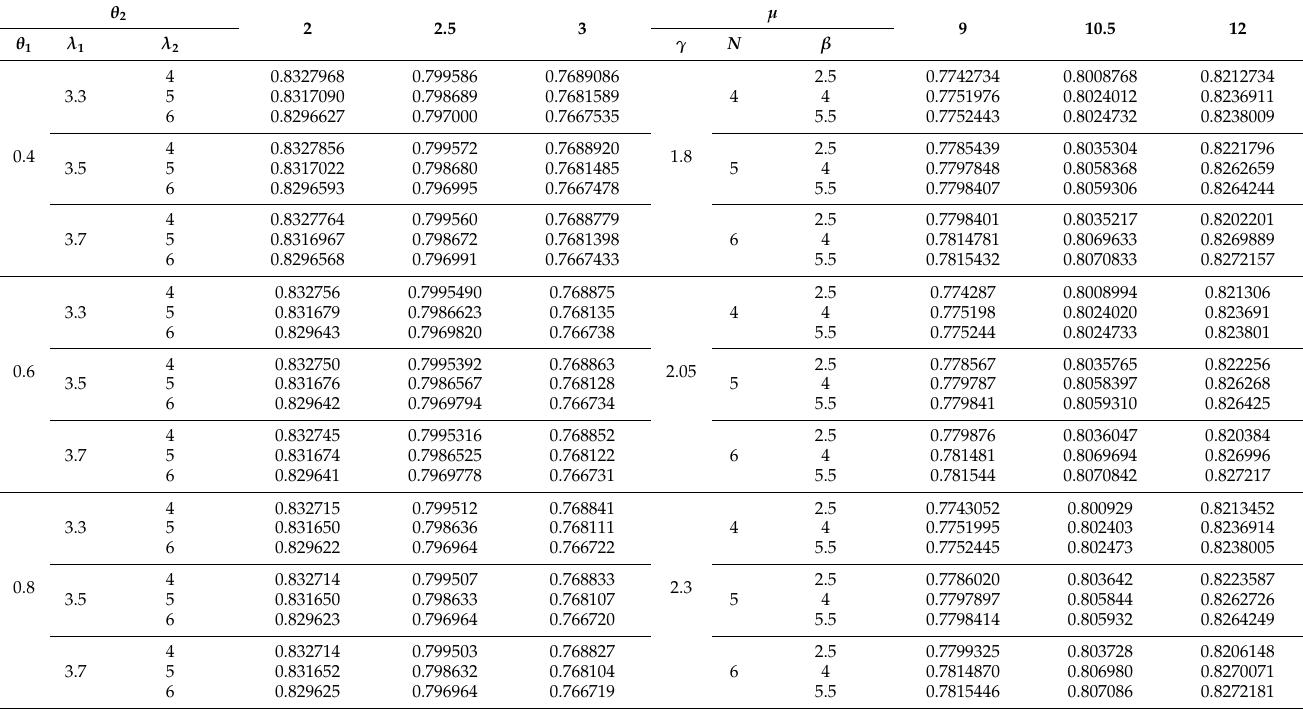
Table 5. F SR under the variation of λ 1 , λ 2 , θ 1 , θ 2 , µ , γ , β , and N